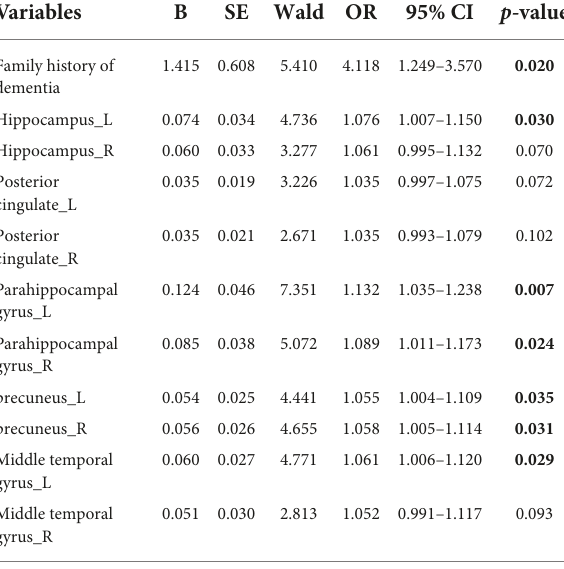
TABLE 3 Univariate logistic regression analyses of risk factors in patients with SCD.